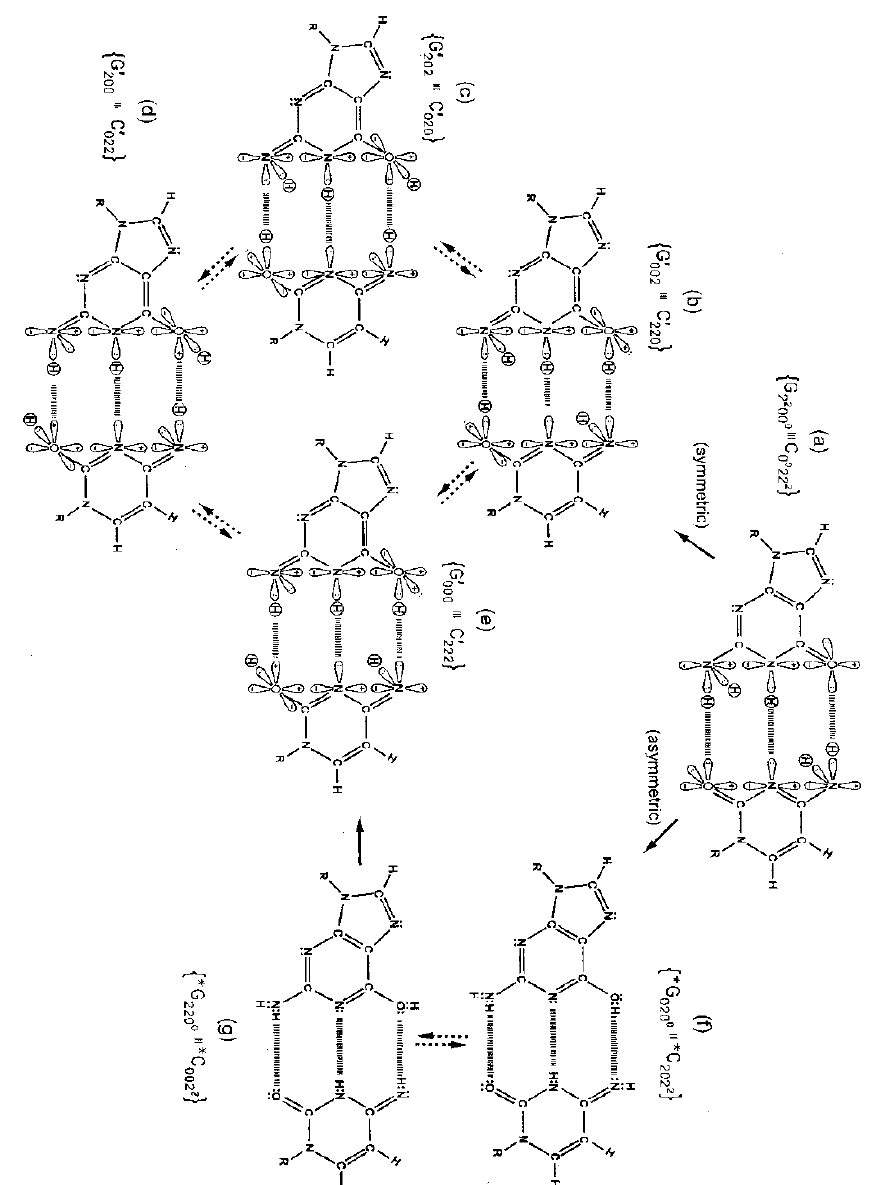
(Symmetric, asymmetric and second asymmetric (unlabeled) channels (→) by which metastable keto-amino G-C protons populate enol-imine states. Dashed arrows identify pathways for quantum mechanical flip-flop of enol-imine protons. Approximate electronic structures for hydrogen bond end groups and corresponding proton positions are shown for the metastable keto-amino duplex (a) and for enol-imine G ′ -C ′ coherent states (b–e). The asymmetric channel introduces the hybrid state superposition, *G-*C (f, g). Electron lone-pairs are represented by double dots and a proton by a circled H. Proton states are specified by a compact notation, using letters G, C, A, T for DNA bases with 2‘s and 0‘s identifying electron lone-pairs and protons, respectively, donated to the hydrogen bond by—from left to right—the 6-carbon side chain (see Figure 1 for numbering of atom positions), the ring nitrogen and the 2-carbon side chain. Superscripts identify the component at the outside position (in major and minor groves) as either an amino group proton, designated by 0 0 , or a keto group electron lone-pair, indicated by 2 2 . Superscripts are suppressed for enol and imine